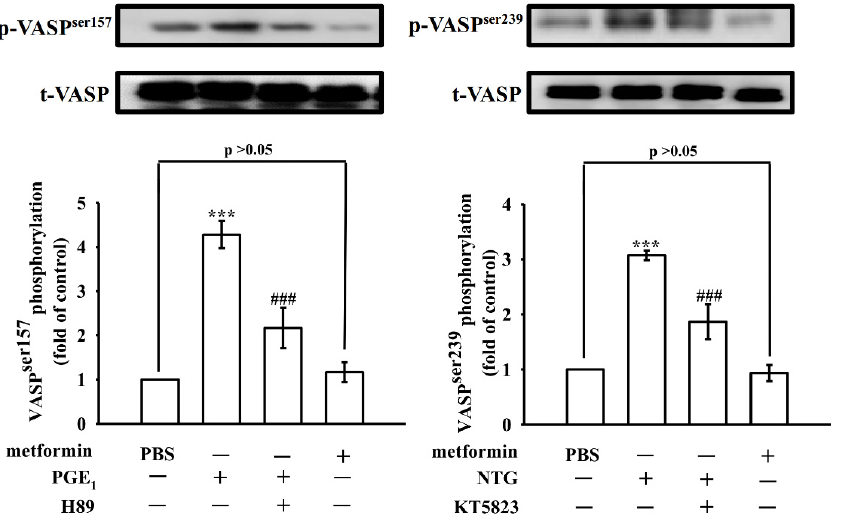
Figure 7. Influence of metformin in vasodilator-stimulated phosphoprotein (VASP) phosphoryla- tion in human platelets. Washed platelets (3.6 × 10 8 cells/mL) were directly stimulated by prosta- glandin E 1 (PGE 1 , 20 nM), nitroglycerin (NTG, 10 μ M), or metformin (1.8 mM) in the presence of H89 (100 μ M) or KT5823 (10 μ M) for immunoblotting of VASP phosphorylation. Results are ex- pressed as mean ± standard error of the mean ( n = 4). *** p < 0.001 vs. PBS-treated group; ### p < 0.001 vs. PGE 1 - or NTG-treated